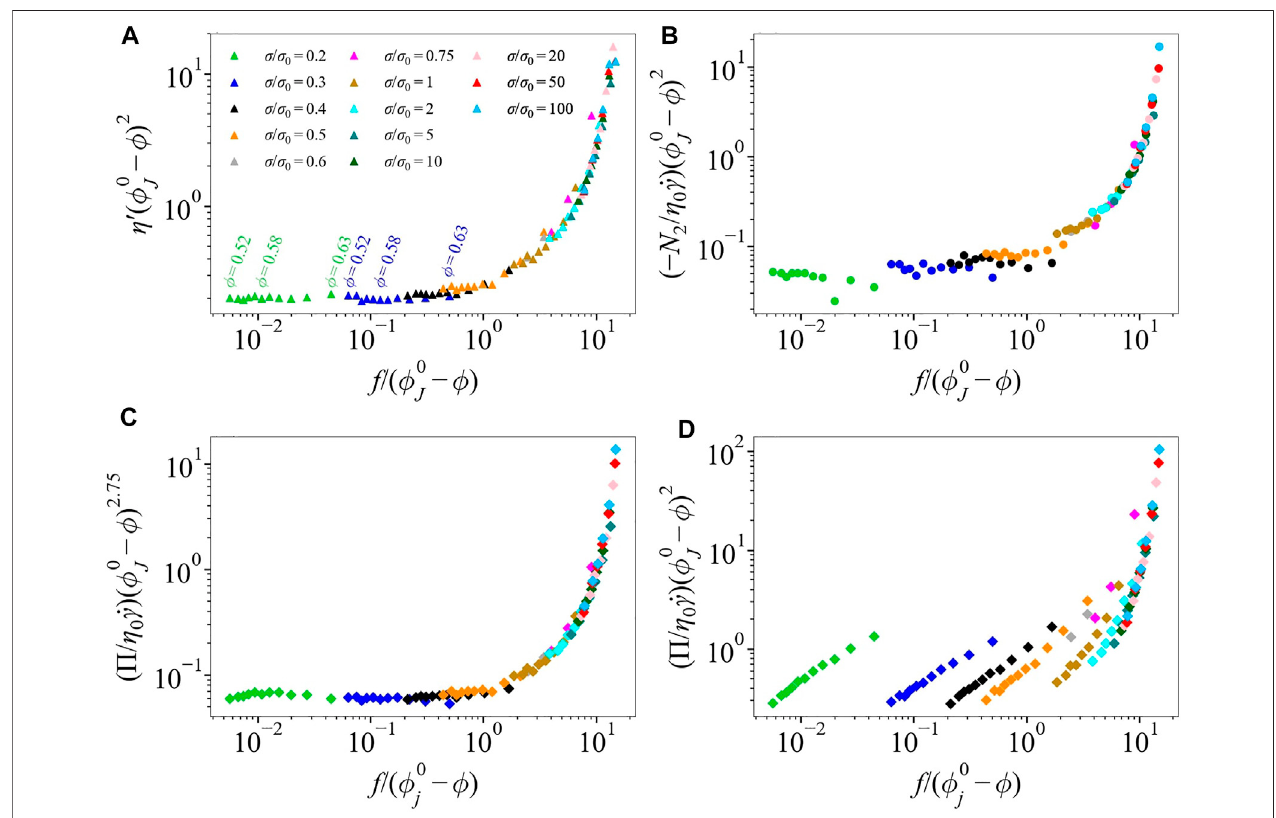
FIGURE2| Thescalingfunctions (A) F η , (B) F N ,and (C) F Π asafunctionofthescalingvariable x (cid:1) f / ( ϕ 0 J − ϕ ) forsimulatedsuspensionsat δ =1.4and ζ =0.50for 2 0.52 ≤ ϕ ≤ 0.63. Note that in (A,B) , η ′ ( ϕ 0 J − ϕ ) 2 and ( N 2 / η 0 _ γ )( ϕ 0 J − ϕ ) 2 collapse, while in (C) ( Π / η 0 _ γ )( ϕ 0 J − ϕ ) 2 . 75 collapses whereas in (D) ( Π / η 0 _ γ )( ϕ 0 J − ϕ ) 2 does not collapse. Data are adapted from Singh et al. [15] and f ( σ ) (cid:1) e ( σ */ σ ) with σ *= 1.45.